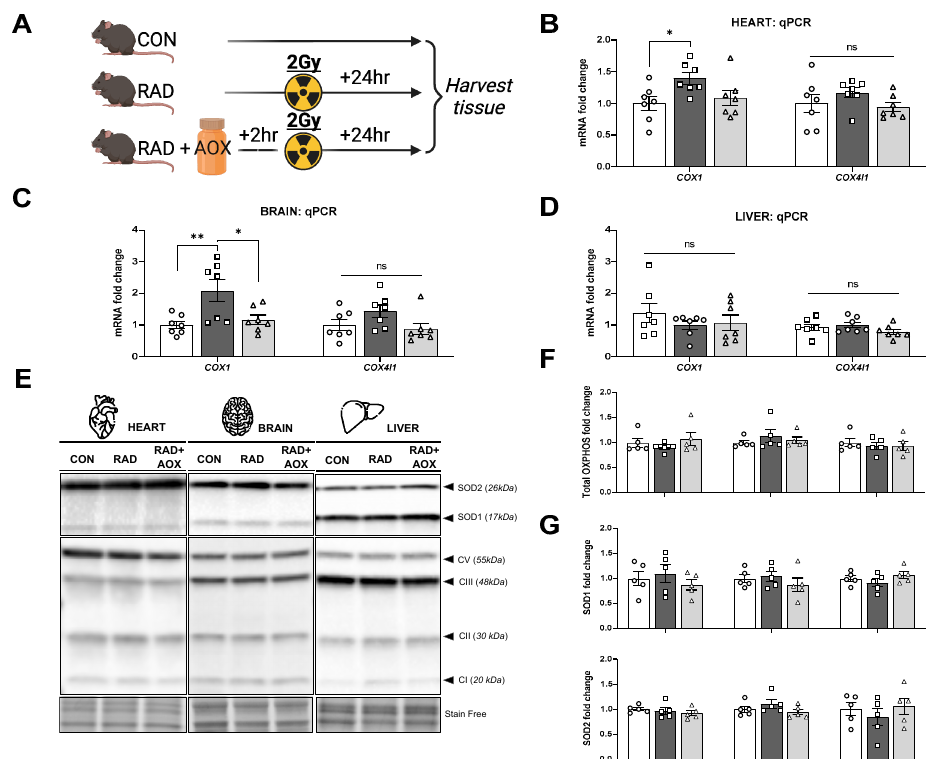
Figure 3. Antioxidant multi-ingredient supplement attenuates increase in COX mRNA abundance. ( A ) Design of experiment. Mice were harvested 24 h following 2 Gy radiation. 2 h prior, mice were gavaged with vehicle placebo (RAD) or antioxidant (RAD + AOX). Control mice (CON) were not gavage fed or irradiated. mRNA abundance for genes of mitochondrial complex proteins I and IV in the ( B ) heart, ( C ) brain, and ( D ) liver were measured using qRT-PCR. Analysis was done using the 2 − ∆ method normalized to B2M housekeeper gene. ( E ) Representative Western blot images for superoxide dismutase I/II proteins (SODI/II) and total OXPHOS proteins, and ( F , G ) densitometric quantification in the heart, brain, and liver. Data is expressed as fold change mean (±SEM) relative to CON. Individual data points shown. Statistical analysis was done with One-way ANOVA with Tukey’s post hoc. *, and ** denote a significant difference between groups of p < 0.05, and p < 0.01, respectively.